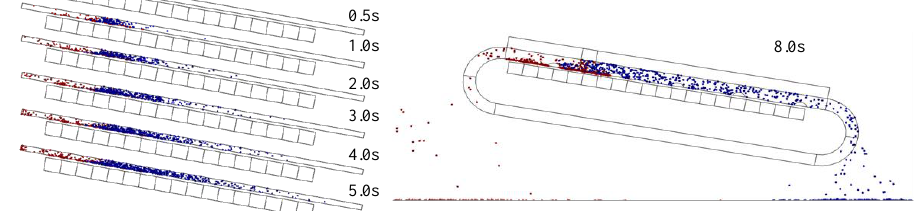
Figure 8. Particle trajectory with magnetic induction 1.0 T in different time.